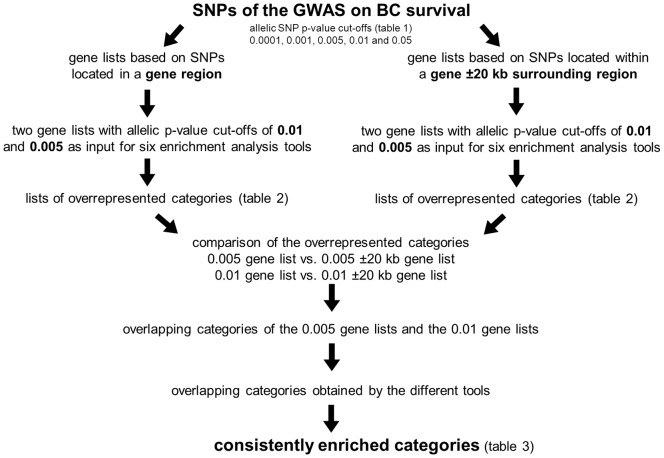
Flow chart of the pathway enrichment analysis of the GWAS on BC survival.